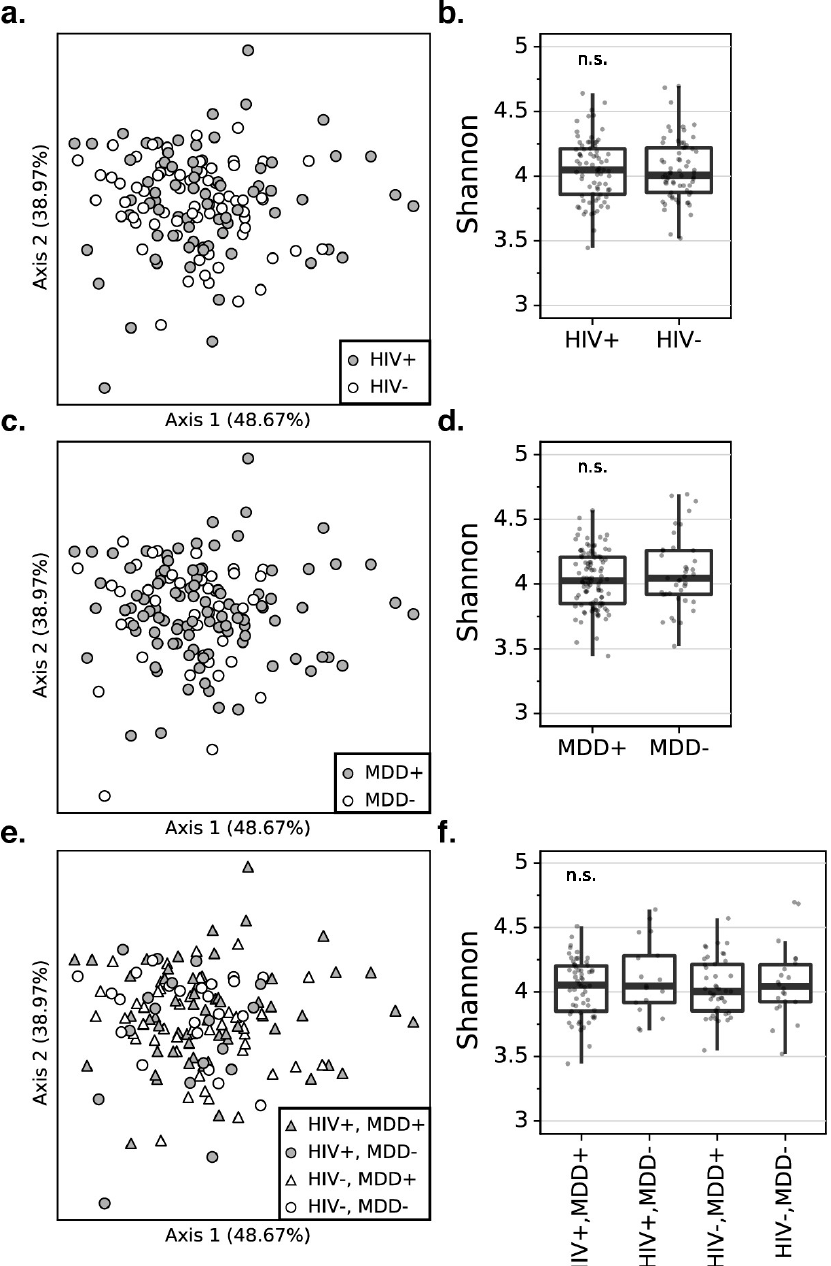
Figure 2. The PCoA plots for the robust principal component analysis (RPCA) distance matrix reveal that there is no significant difference in the beta diversity between PWH and PWoH ( a ), participants with and without MDD ( c ), and combined HIV and MDD groups ( e ). The percentage of the total variance is presented by each axis. The box plots represent that there is no significant difference in the alpha diversity using the Shannon index between PWH and PWoH ( b ), participants with and without MDD ( d ), combined HIV and MDD groups ( f ). PWH: people with HIV, PWoH: people without HIV, MDD: major depressive disorder.